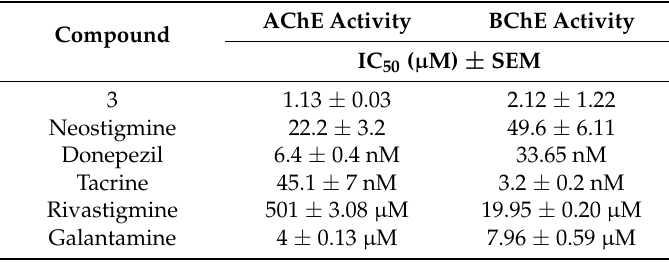
Table 1. Dual AChE and BChE inhibition